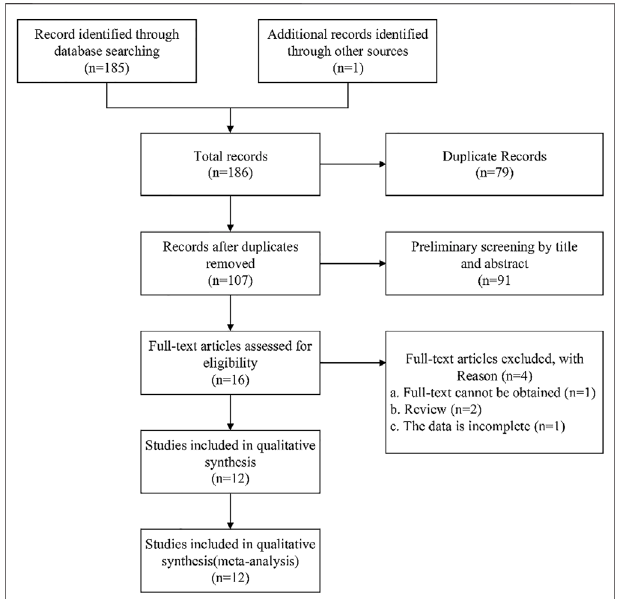
FIGURE 1 | Flow chart of literature screening.